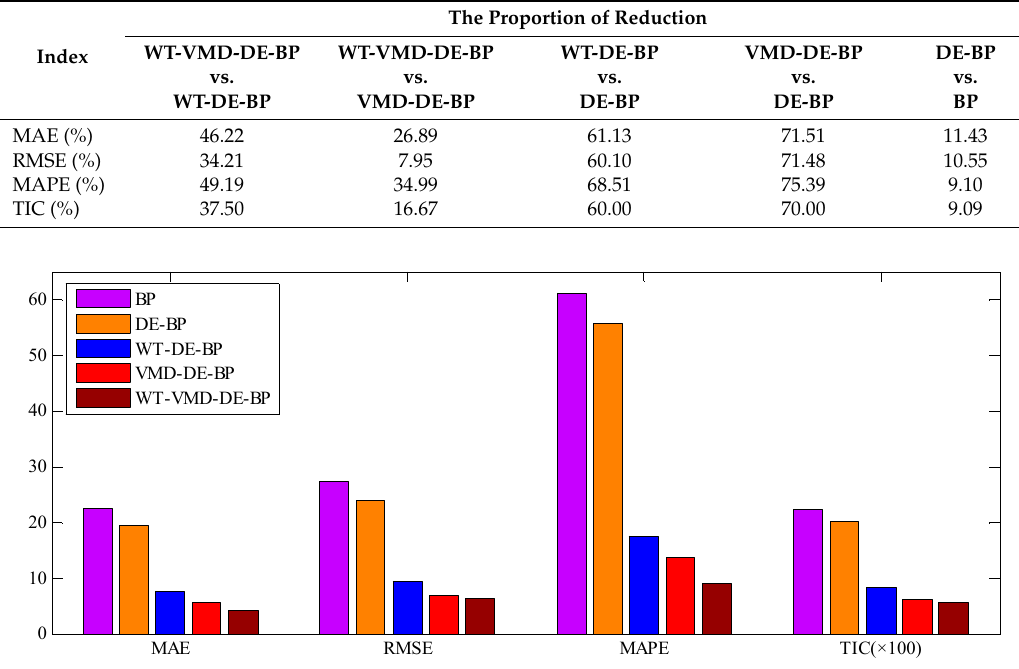
Figure 19. Error graphics of different models (Tianjin).